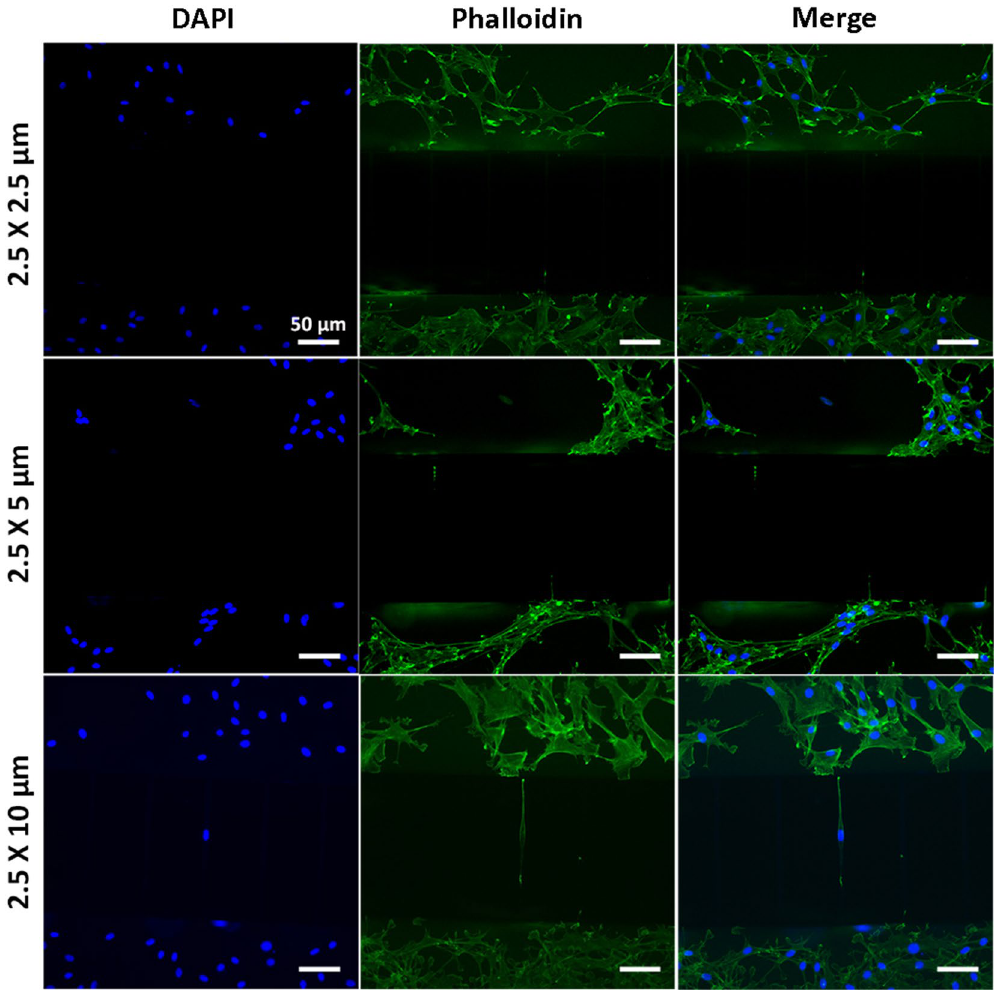
Figure 5. Fluorescent images of primary rat Schwann cells cultured on devices having microchannels with different height × width section. DAPI and phalloidin-FITC stained primary rat Schwann cells showed how only 2.5 × 5 µm geometry permitted cell protrusions, preventing nuclei migration. Scale bar: 50